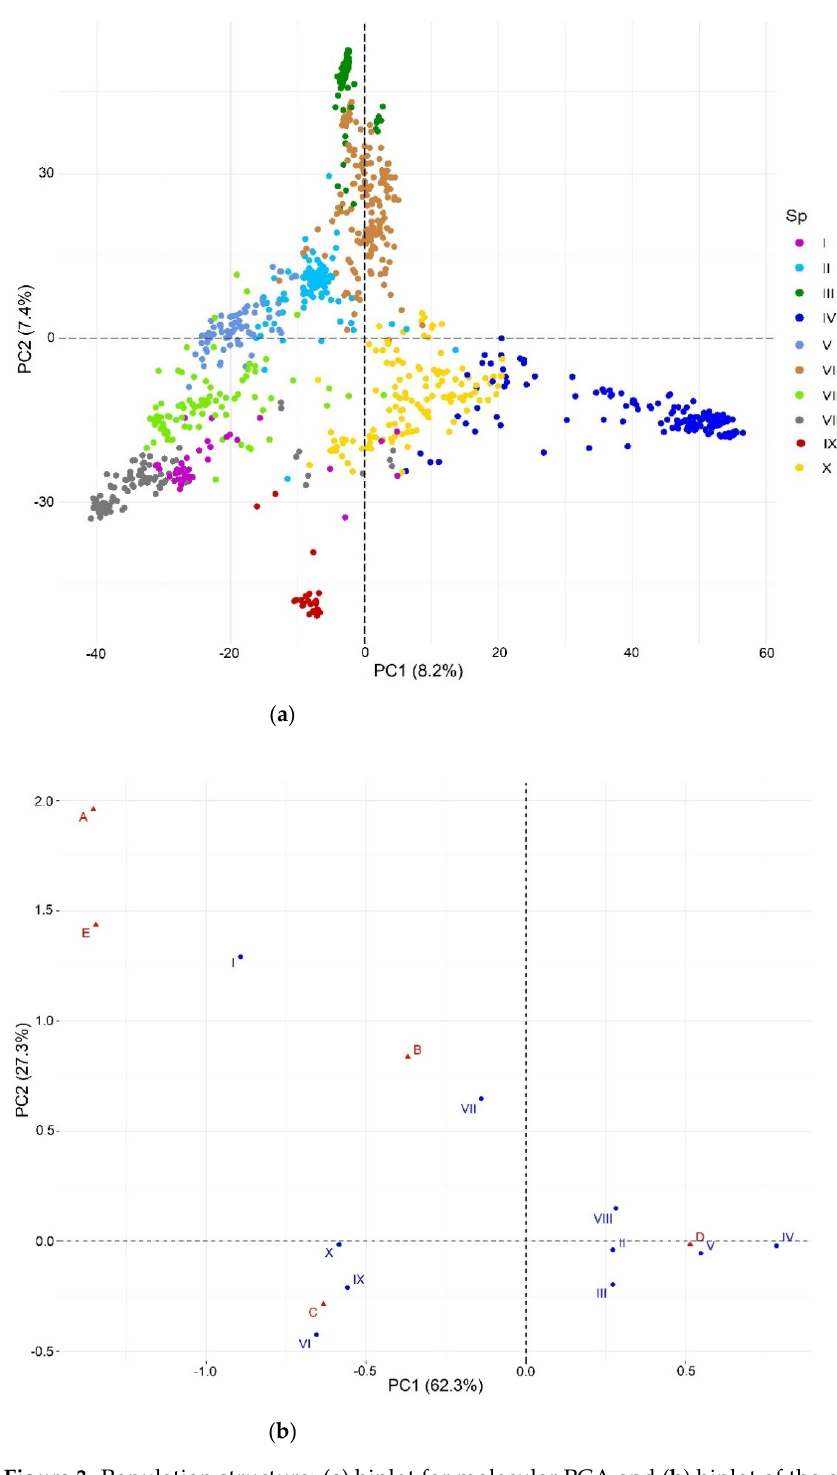
Figure 3. Population structure: ( a ) biplot for molecular PCA and ( b ) biplot of the correspondence analysis, where A = Tropical, B = Dry, C = Temperate, D = Continental, and E = Polar.